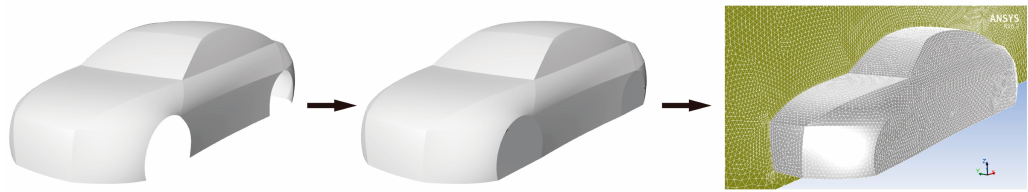
Figure 13. The pretreatment of computational fluid dynamics (CFD) on the the model